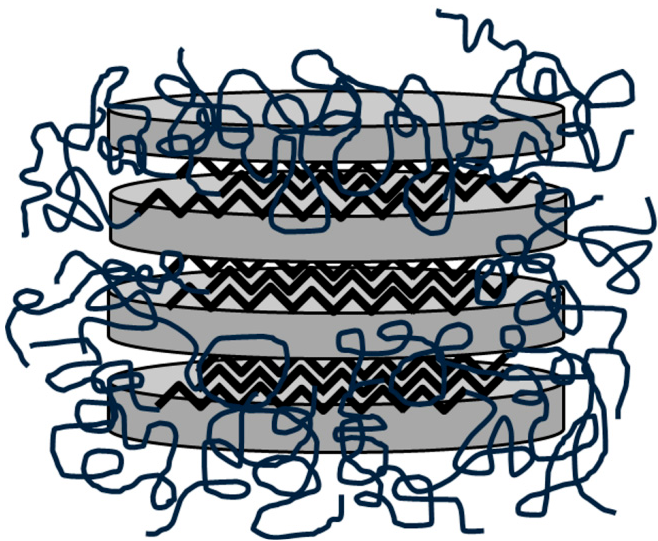
Figure 13. Schematic showing PI chains emanating from the Laponite ® platelets filled with PEO chains (“hairy”